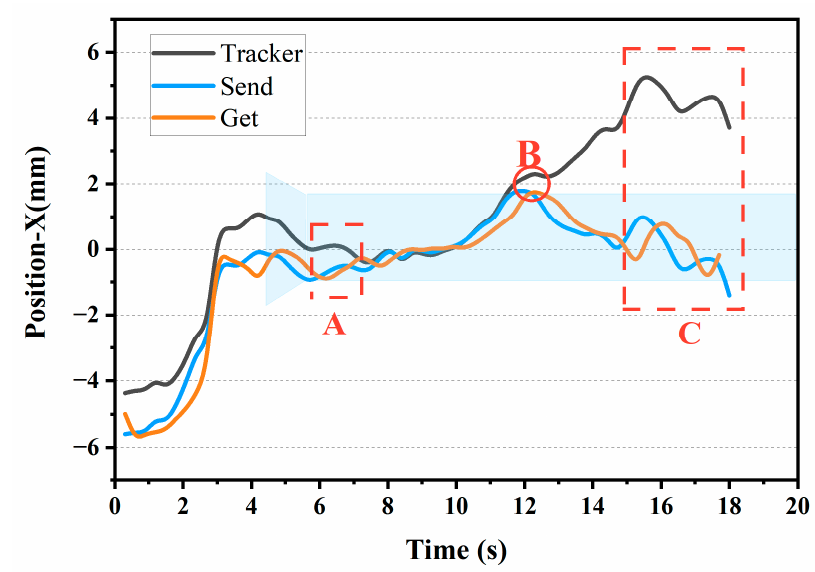
Figure 10. The position in the X direction by the integrated position/force controller. The blue background in the figure represents the geometry of the assembly hole.